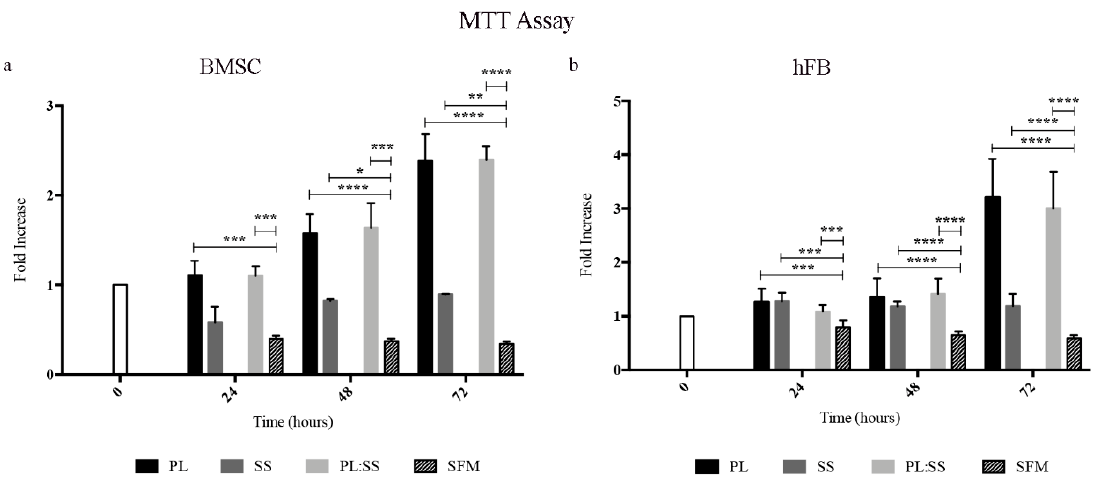
Figure 4. Cell viability with biomembrane components. Analysis of bone marrow mesenchymal stromal cells (BMSC) ( a ) and human skin fibroblasts (hFB) ( b ) viability and capacity of cells to proliferate following the PL stimulation in the presence of SS. Cells were maintained up to 72 h in Serum-free medium (SFM), or SFM supplemented with PL (PL), Sericin (SS), PL and Sericin (PL:SS). Cell viability was determined by a Thiazolyl blue staining (MTT assay), **** p < 0.0001, *** p < 0.001, ** p < 0.01, * p < 0.05.